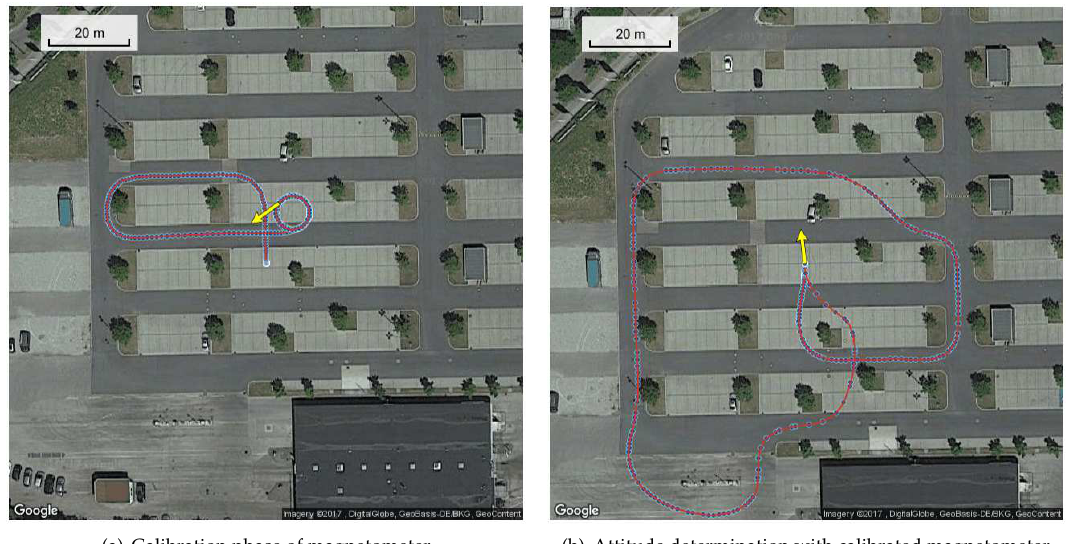
Figure 4. Maps with track of vehicle, split into two processing steps.